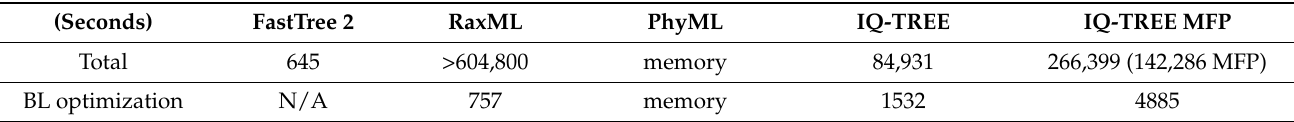
Figure 3. Metrics of phylogenetic inference accuracy for FastTree, IQ-TREE (GTR), IQ-TREE (MFP), RAxML-NG, and PhyML on 10 simulated replicate datasets of HIV, HCV, and Ebola. Phylogenies which result from optimizing branch lengths along FastTree topology are also included. Violin plots are shown for URF, WRF, Pearson Mantel Correlation, and Mean Squared Error. Violin plots showing Spearman Mantel Correlation can be found in Supplementary Figure S1. Table 1. Total runtime for phylogenetic inference (top row) and runtime of branch length optimization on a fixed topology (bottom row) for FastTree 2, RAxML, IQ-TREE (GTR), and IQ-TREE MFP on a curated MSA of 2322 HIV-1 whole genome sequences from LANL. PhyML was unable to execute due to high memory consumption. All runs were executed sequentially on a 4-core 3.5 GHz Intel i5-6600k with 16 GB of memory, and each tool automatically selected an optimal number of threads to use